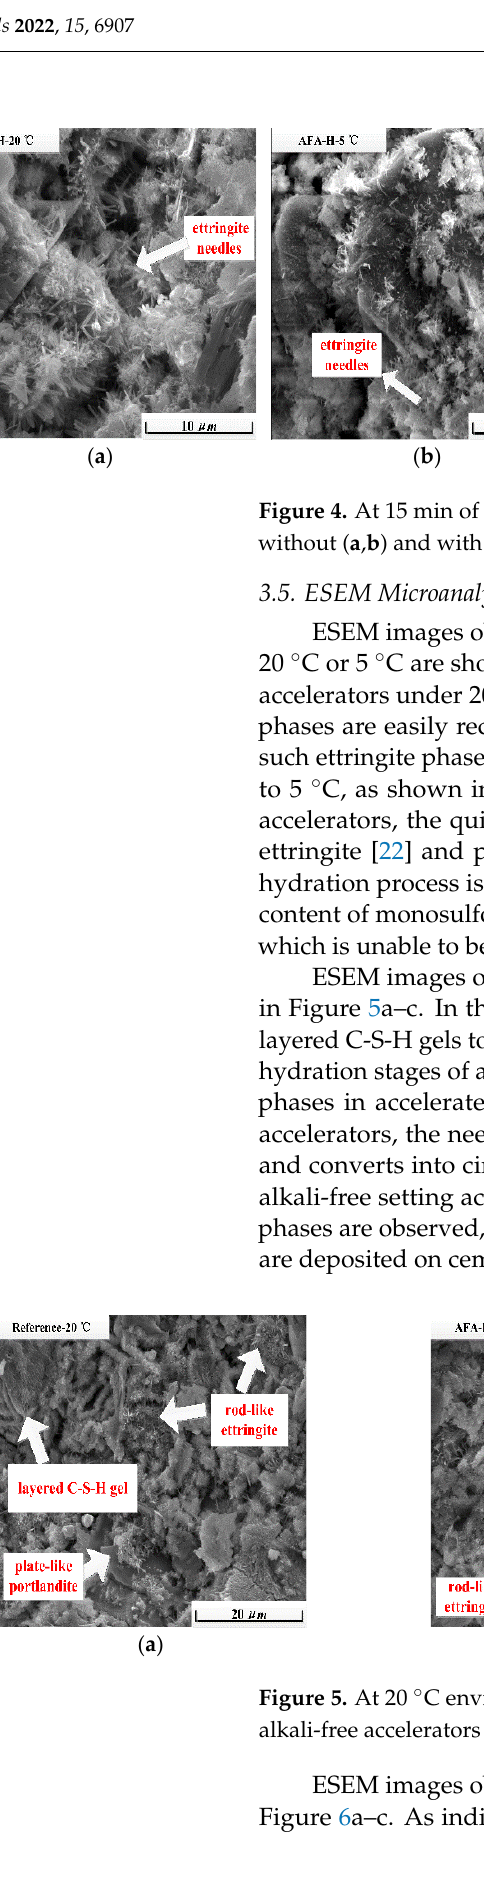
( b ) ( c ) Figure 6. At 5 °C environment temperature, ESEM images of cement paste with reference one ( a ), alkali-free accelerators without fluoride ( b ), and with fluoride ( c ) at 24 h of hydration. 4. Conclusions This study mainly evidences how early age hydration and setting and hardening characteristics of a type of reference cement are affected by low environment temperatures in the presence of different alkali-free accelerators. The results obtained from physico- chemical experimental tests support the performance difference of wet-mix shotcrete ac- celerated by alkali-free accelerators with or without fluoride compounds, such as the abil- ity to shorten setting times and early age hydration behavior. The following conclusions can be drawn based on the analysis results using different experimental methods. (1) Compared with that with the non-fluoride alkali-free accelerators, alkali-free accel- erators composed of aluminum sulfate and fluoride compounds promote the alite minerals dissolution and more calcium and silica ions are released in the liquid phase of the cement paste. Depending on the sufficient sulfate obtained in the setting accel-